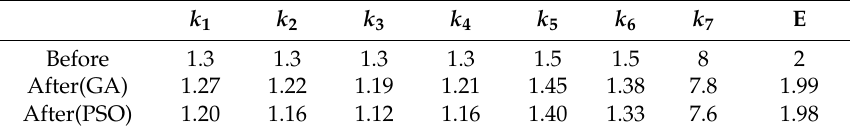
Table 7. Value of uncertain parameters before and after updating.